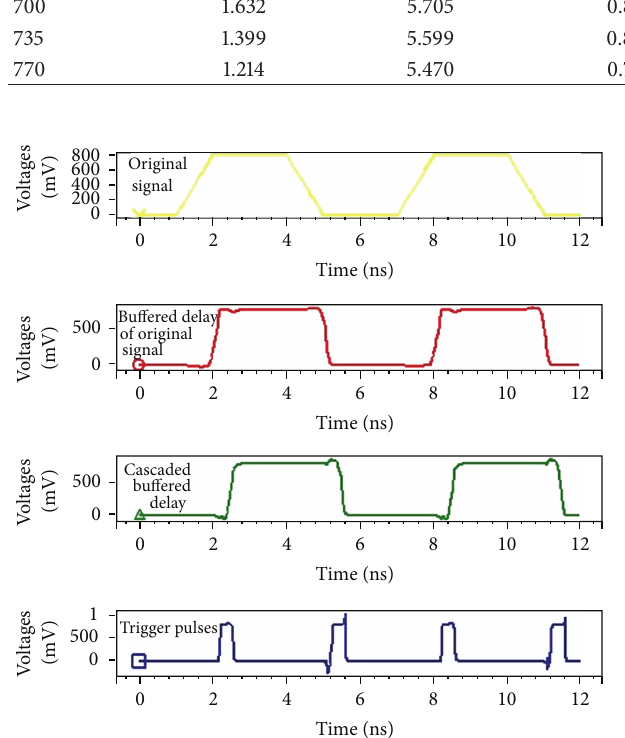
Figure 10: Output waveform of the trigger pulse